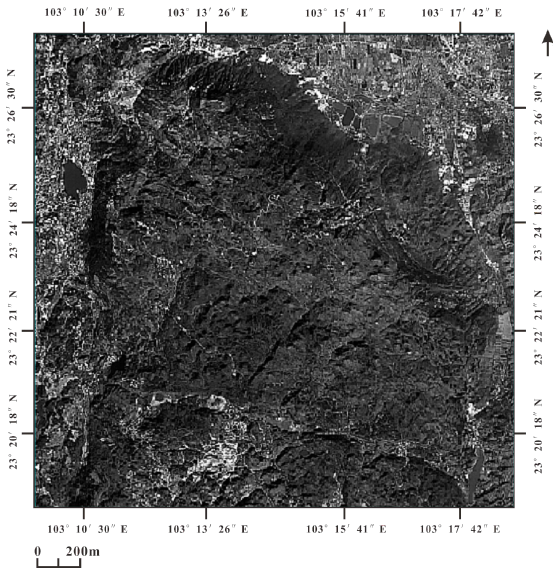
Figure 7. Image data after Gaussian low-pass filtering.